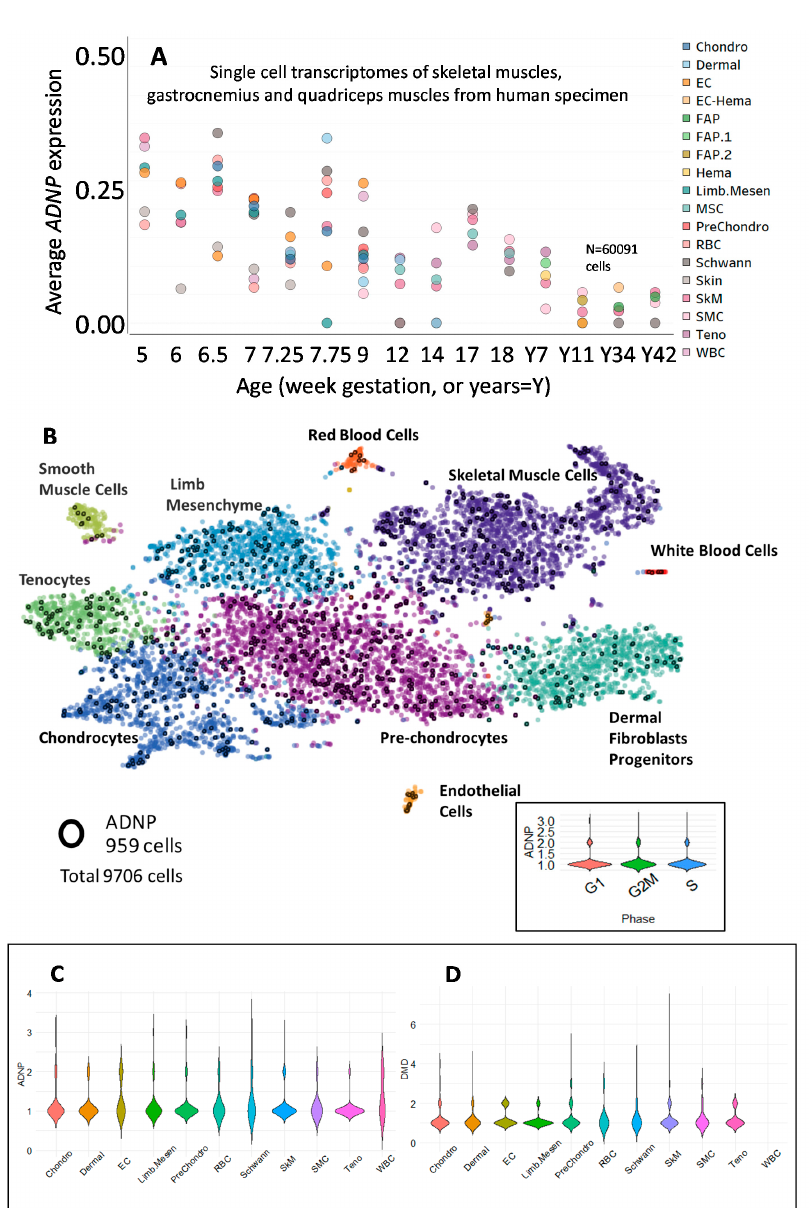
Figure 1. ADNP is expressed in the single human muscle cell. Single-cell transcriptomes of skeletal muscles, gastrocnemius, and quadriceps muscles from a human specimen (GEO dataset GSE147457). ( A ) Average expression levels of ADNP for each cell type and through developmental weeks 5–18 and years 7, 11, 34 42. n = 60,091 cells. ( B ) ADNP-expressing cells are marked in black-2D plots of single cells, visualized by the t-SNE algorithm, UCSC Cell Browser [40]. Inset: Violin plot of ADNP expression levels in single cells in phases G1, G2M, and S. n = 9706 cells. ( C , D ) Violin plots of single-cell expression levels of ADNP and DMD in each cell type. Chondro = Chondrocytes, Dermal = Dermal Fibroblasts Progenitors, EC = Endothelial Cells, EC-Hema = Endothelial, and Hematopoietic Cells, FAP = Fibro-adipogenic Progenitor, Hema = Hematopoietic Cells, Limb. Mesen = Limb Mesenchyme, MSC = Mesenchymal Stromal Cells, PreChondro = Pre-chondrocytes, RBC = Red Blood Cells, Schwann, SkM = Skeletal Muscle Cells, SMC = Smooth Muscle Cells, Teno = Tenocytes, WBC = White Blood Cells